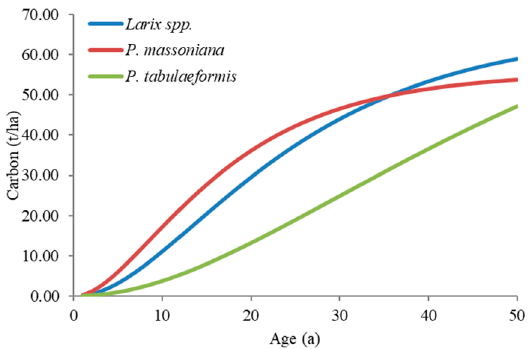
Figure 4. The fitting effect of carbon growth in the P. tabuliformis plantation.